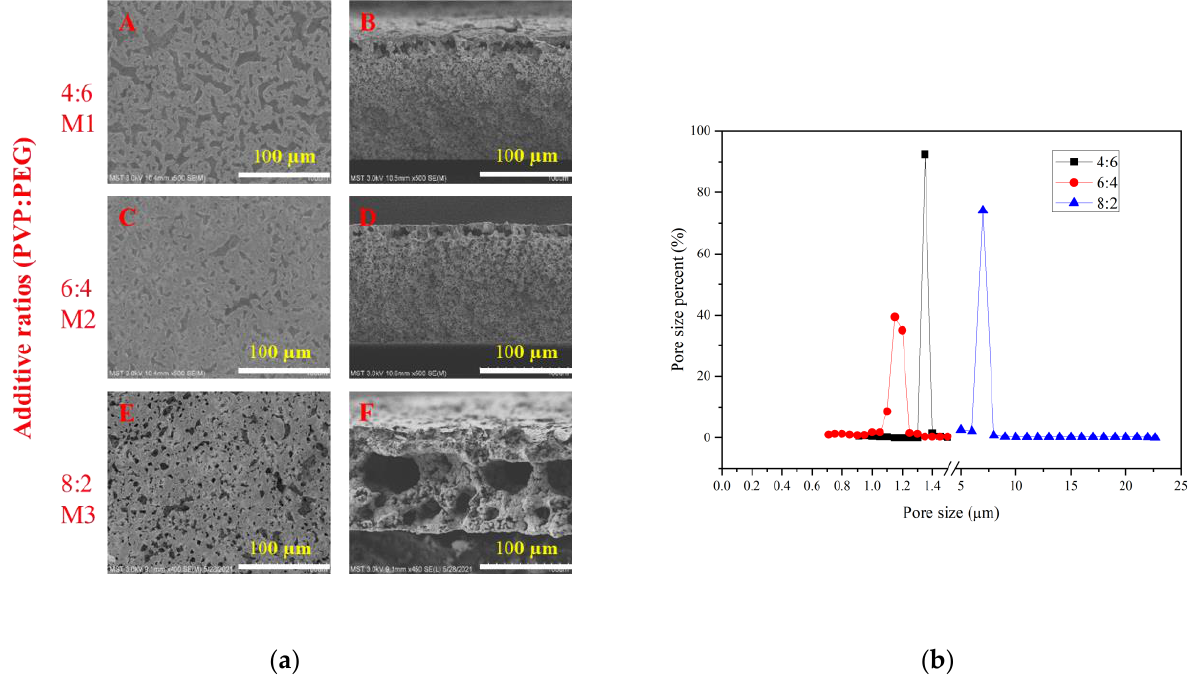
Figure 4. ( a ) SEM images of PVDF membranes prepared with different additive ratios of ( A , B ) 4:6, ( C , D ) 6:4 and ( E , F ) 8:2. ( b ) Pore size distribution of PVDF membranes prepared with different additive ratios. Table 2. Viscosity of casting solution with different additive